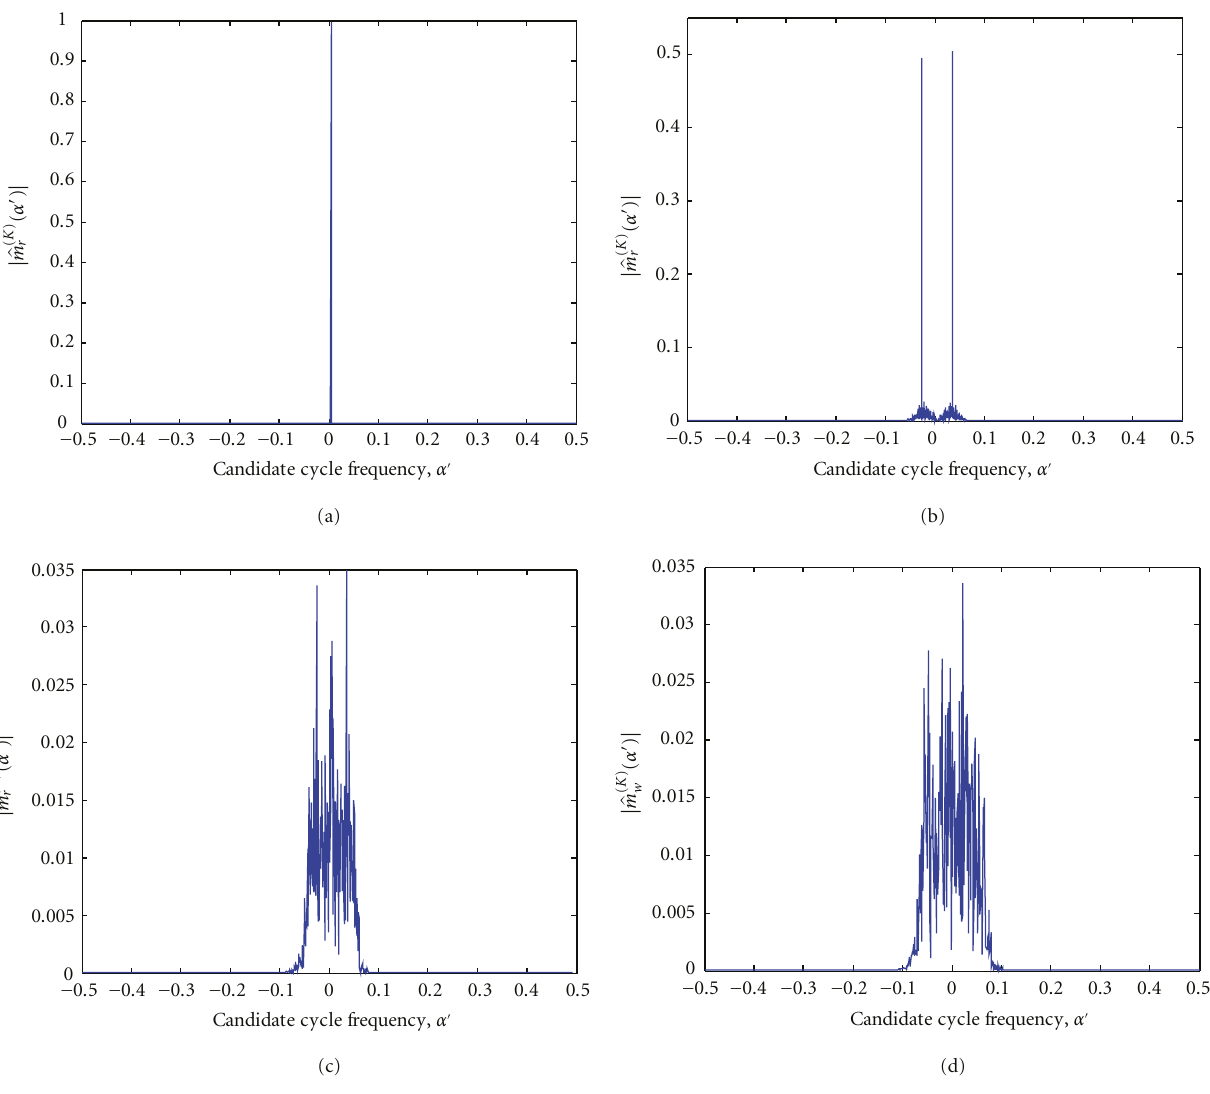
Figure 3: The magnitudes of the first-order estimated CM at candidate CFs α (cid:8) , α (cid:8) ∈ [ − 1 / 2,1 / 2), for (a) AM, (b) 2-FSK, (c) 2-PSK signals at 20dB SNR, and (d) noise with power